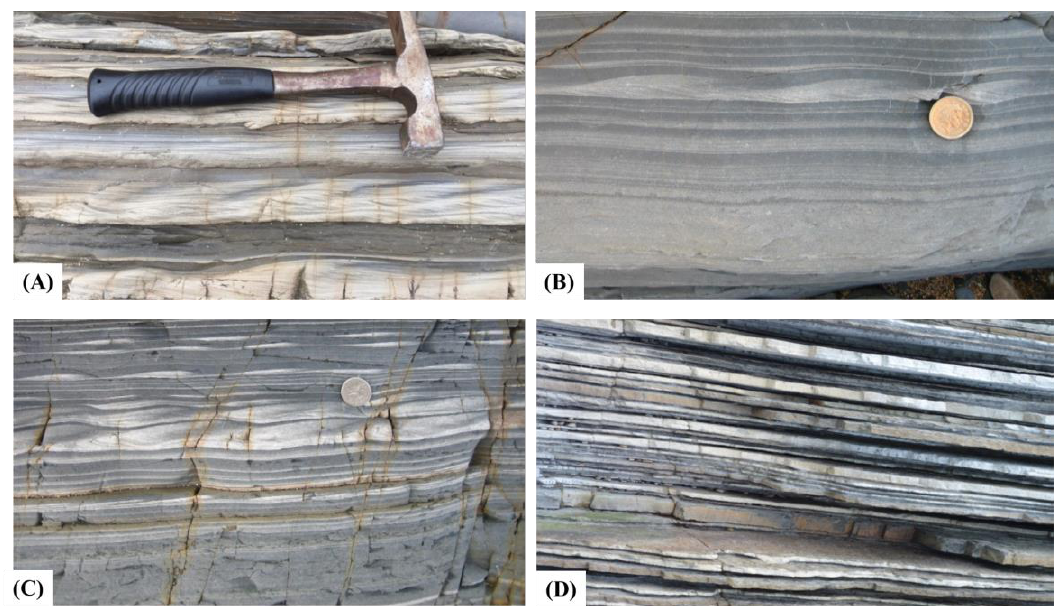
Figure 12. Fine-grained turbidite family, variously interbedded with other turbidite and related facies: photographic examples. ( A ) Very-thin-bedded turbidites (sand / silt to mud) with partial Stow sequences. Note distinctive faded-ripple basal divisions (Stow T0), long-wavelength low-amplitude ripples (lenticular lamination, Stow T2) and parallel silt–mud lamination (Stow T3). ( B ) Very-thin-bedded turbidites (silt to mud) with partial Stow sequences (as above). Note also that the lower bed is a disorganised fine-grained turbidite. ( C ) Very-thin-bedded turbidites (silt to mud) with partial Stow sequences (as above), including upper muddy divisions (Stow T4–6). ( D )—Thin-bedded and very-thin-bedded turbidite succession (sand, silt and mud), Aberystwyth Grits, Wales. Width of view is 0.75 m.